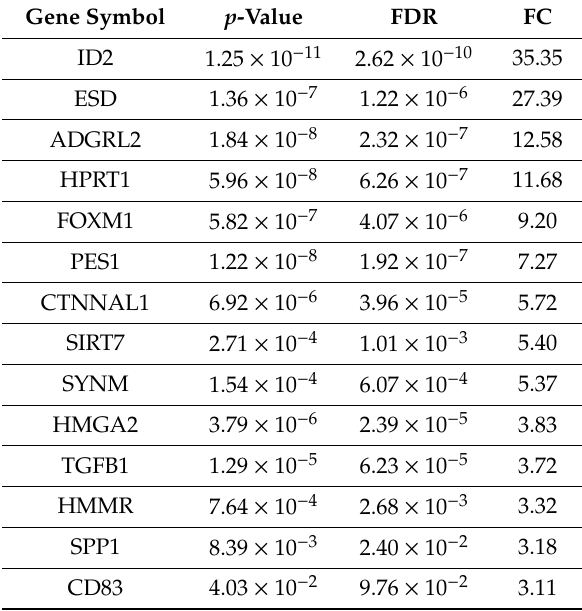
Table 3. DEGs emerged in A2780 cells after 48 h co-culture with A1-derived ML-Ddx4 +